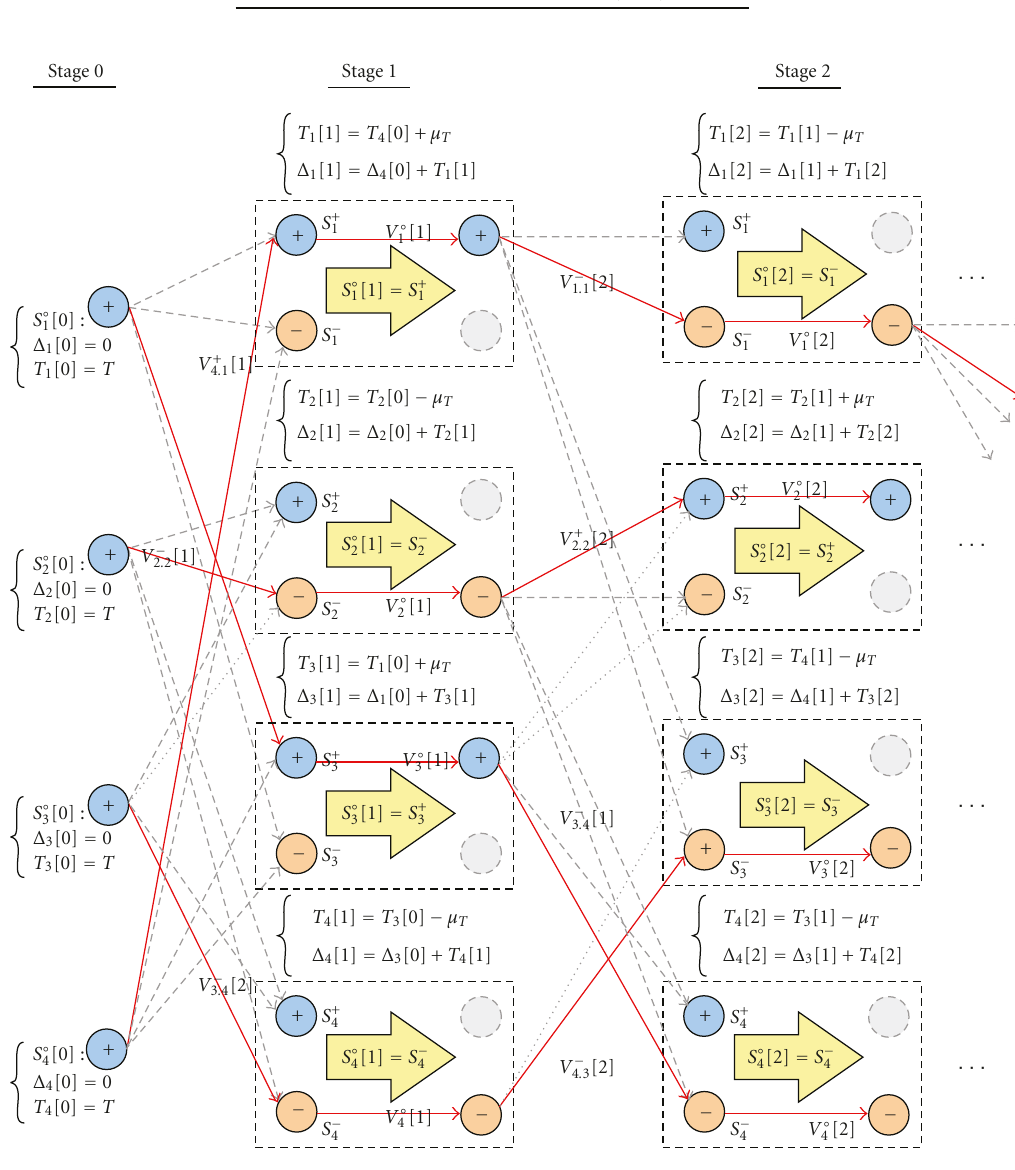
Figure 4: Illustration of the JVSS